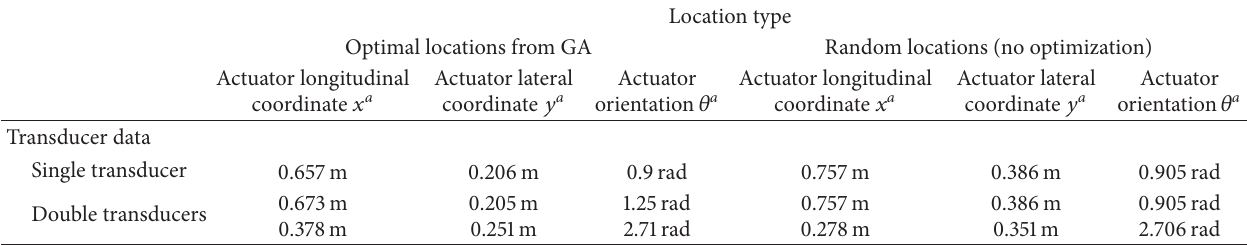
Table 8: GA-optimal and random configurations of piezoelectric transducers attached to the rectangular plate. The first two modes are the dominant modes, while the next three modes are the residual modes.